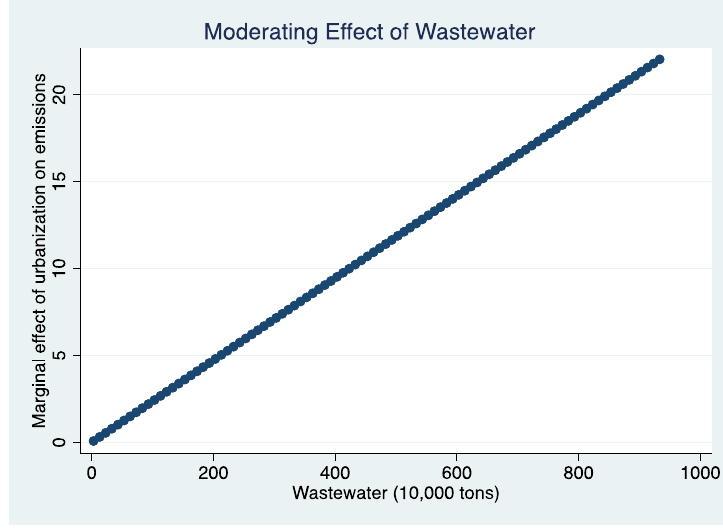
Figure 11. Moderating effect of transportation.